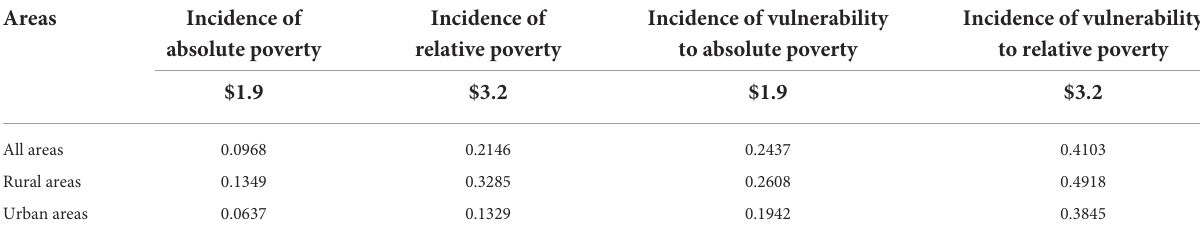
TABLE 1 Descriptive statistics of incidence of poverty and vulnerability to poverty.